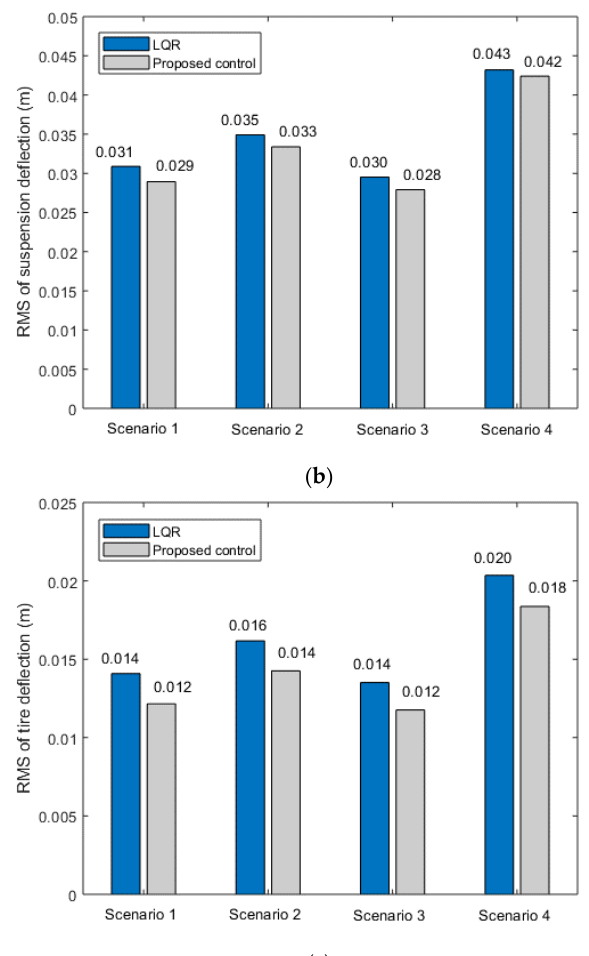
Figure 6. Performance index comparison between different scenarios. ( a ) Body vertical acceleration; ( b ) suspension deflection; ( c ) tire deflection.